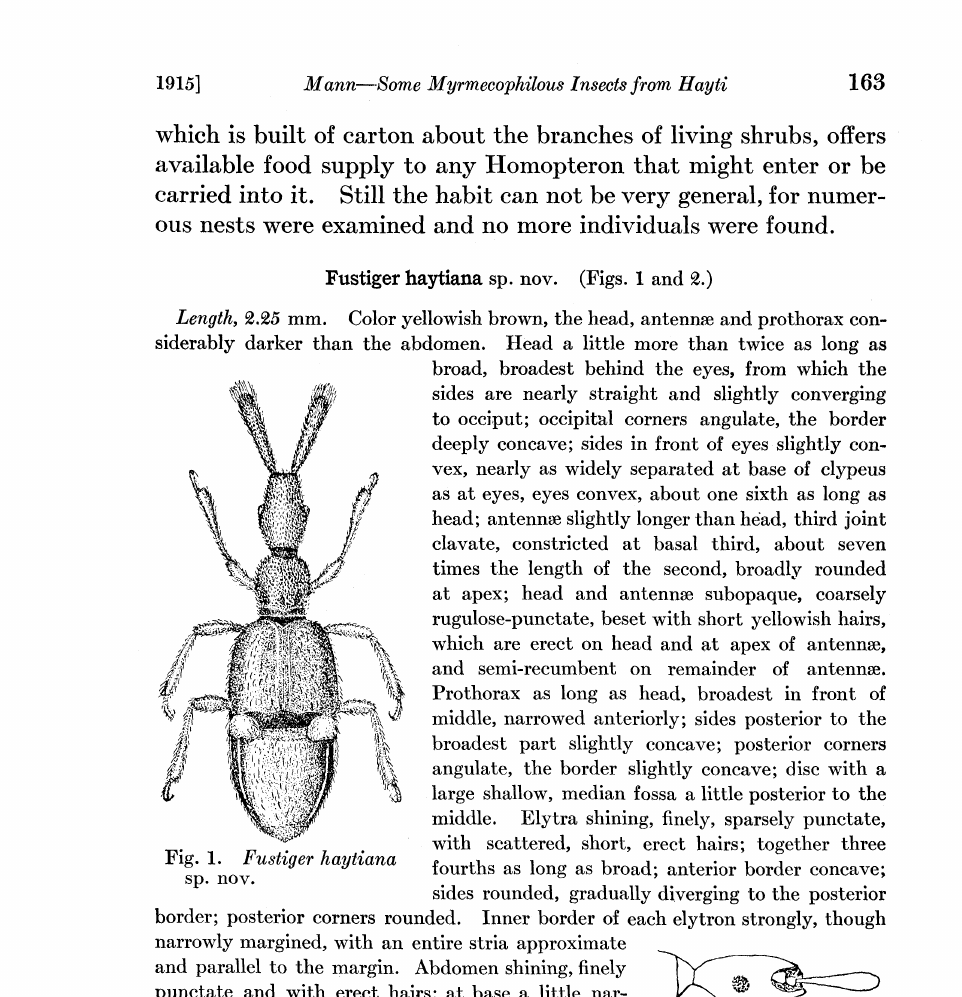
sides are nearly straight and slightly converging to occiput; occipital corners angulate, the border deeply concave; sides in front of eyes slightly con- vex, nearly as widely separated at base of clypeus as at eyes, eyes convex, about one sixth as long as head; antennae slightly longer than head, third joint clavate, constricted at basal third, about seven times the length of the second, broadly rounded at apex; head and antennae subopaque, coarsely rugulose-punctate, beset with short yellowish hairs, which are erect on head and at apex of antennae, and semi-recumbent on remainder of antennae. Prothorax as long as head, broadest in front of middle, narrowed anteriorly; sides posterior to the broadest part slightly concave; posterior corners angulate, the border slightly concave; disc with a large shallow, median fossa a little posterior to the middle. Elytra shining, finely, sparsely punctate, with scattered, short, erect hairs; together three Fig. 1. Fustiger haytiana fourths as long as broad; anterior border concave; sp. nov. sides rounded, gradually diverging to the posterior border; posterior corners rounded. Inner border of each elytron strongly, though narrowly margined, with an entire stria approximate and parallel to the margin. Abdomen shining, finely punctate and with erect hairs; at base a little nar- rower than the elytra; first segment basally very deeply impressed transversely and having on either side of this ..depression a large rounded tubercle which bears a thin bunch of short, recumbent hairs; sides rounded, margined, with strong strie that extend from the middle of tubercles to the apical Fig. 2. Fustiger haytiana corners of first segment. sp. nov. above, head from side; below, mid- dle femur. Middle femora with a long, curved, blunt process near the base. Ventral surface shining, minutely